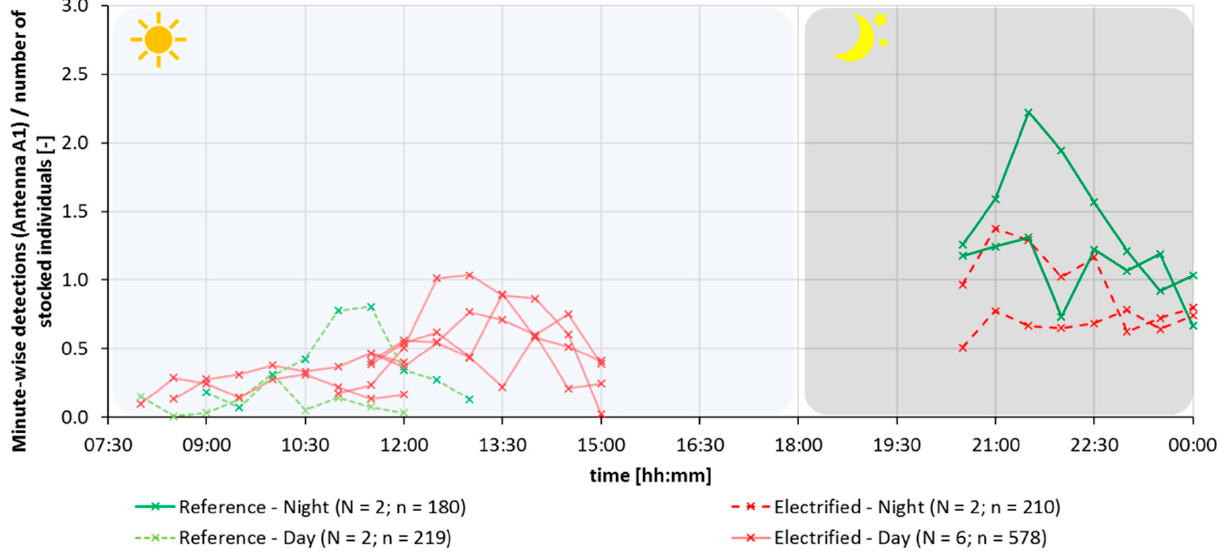
Figure 4. Fish activity including all species for individual trials plotted as the number of minute-wise detections on Antenna A1 (upstream of the bar rack) divided by the number of stocked fish per trial (n, standardization) over time [hh:mm]. Reference trials in green, treatments in red. Data-points are plotted in 30-min intervals. Data points are indicated with crosses. Number of trials per condition is denoted N, number of stocked fish per conditions is denoted n. Increased activity patterns during the night with distinct peak.